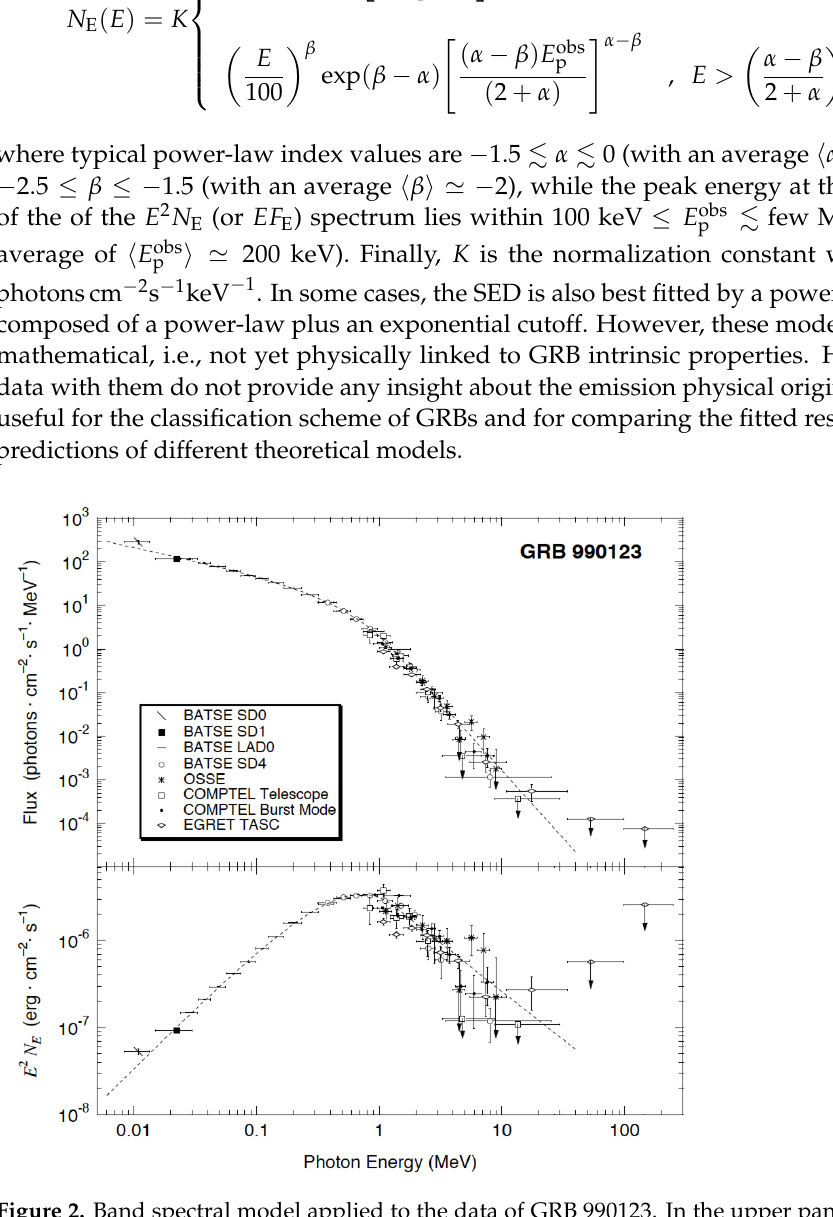
Figure 2. Band spectral model applied to the data of GRB 990123. In the upper panel, the photon spectrum is shown; in the lower panel, the E 2 N E (or EF E ) spectrum is shown. Courtesy from Ref.